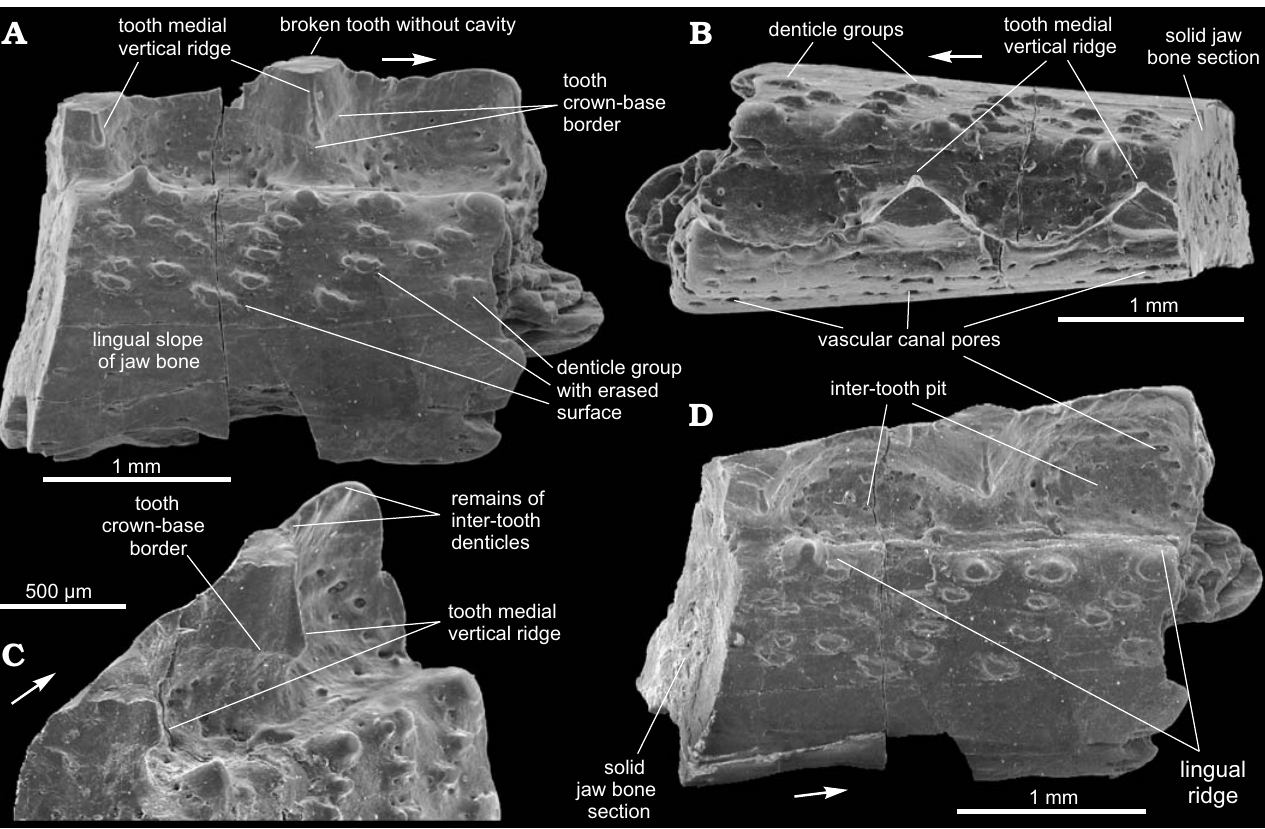
Fig. 7. Podoliacanthidae fam. nov. gen. et sp. indet., ZPAL P.14/12.10, Dniester River, on the east outskirts of Ivanie Zolote; upper part of the Ivanie Horizon of the Tyver Series, Lower Devonian; jaw bone fragment in lingual ( A ), occlusal ( B ), and linguo-occlusal ( D ) views, postero-lingual view of lateral tooth row ( C ). Arrows indicate rostral